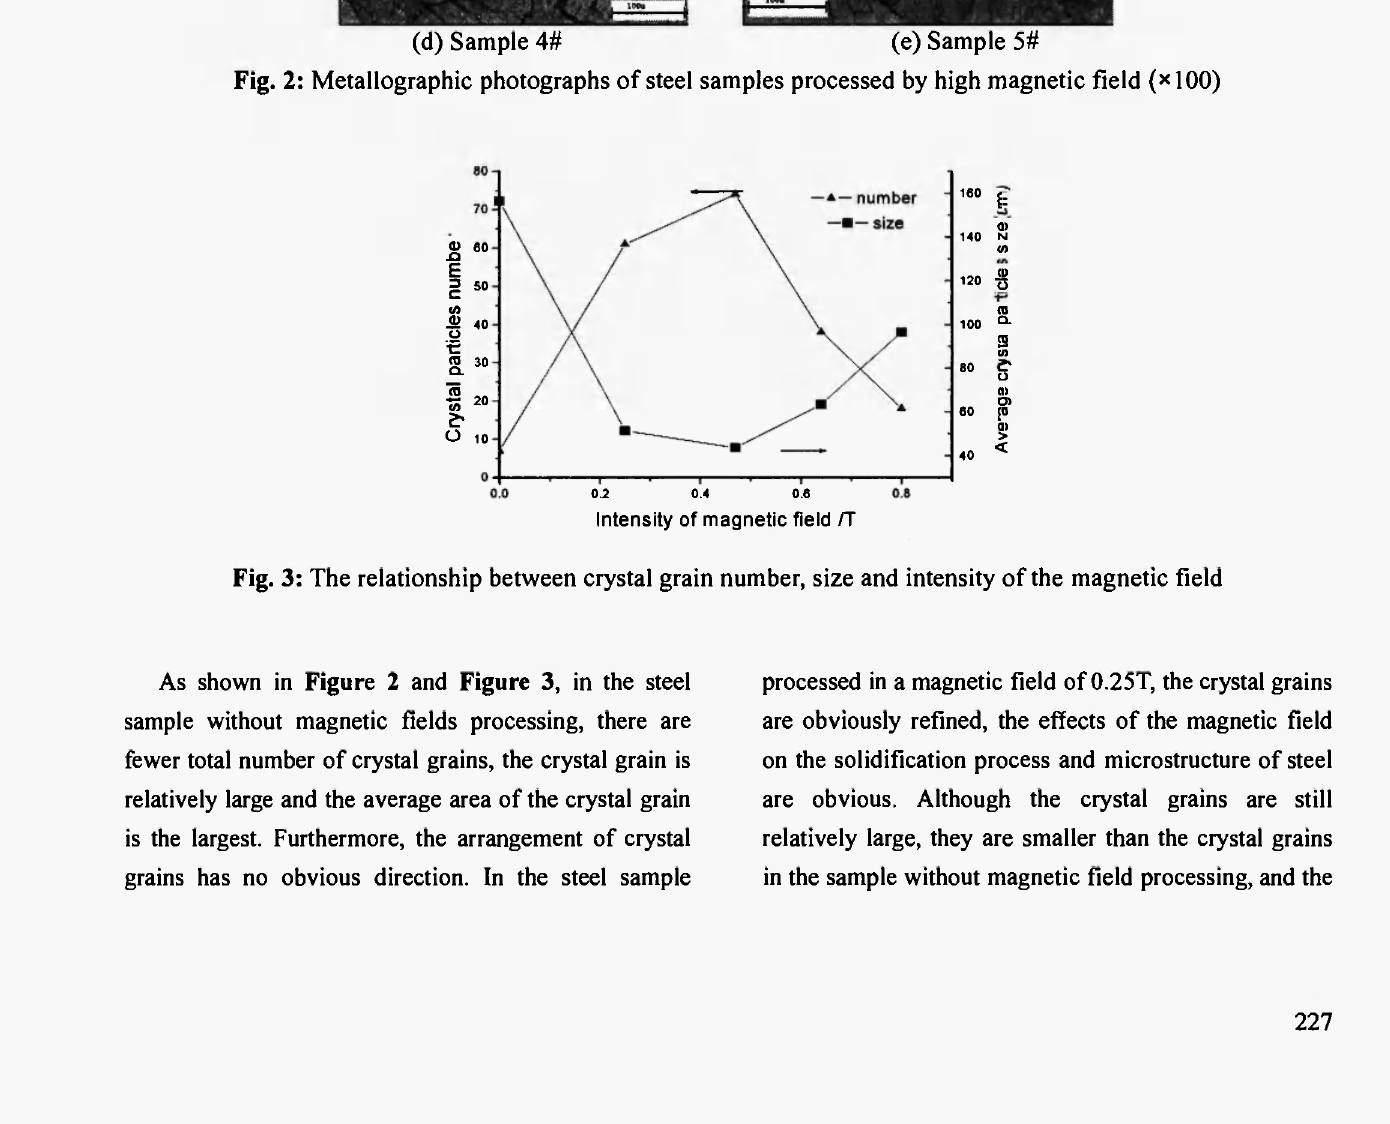
Fig. 2: Metallographic photographs of steel samples processed by high magnetic field (χ 100)